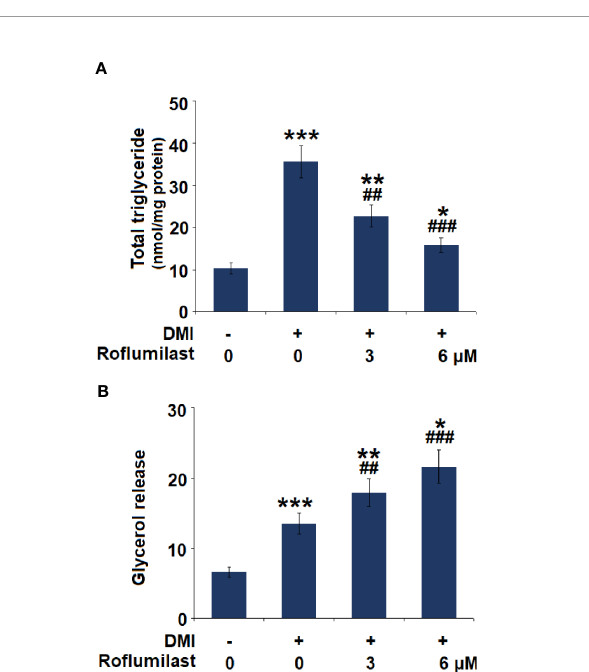
FIGURE 2 | Effect of Ro fl umilast on adipogenesis in 3T3-L1 cells. Cells were incubated with differentiation cocktail (DMI) medium with Ro fl umilast (3 and 6 m M). (A) Cells were stained with Oil Red O on day 8; (B) Lipid accumulation was examined by measuring absorbance at 540 nm of Oil Red O (*, **, ***, P < 0.05, 0.01, 0.005 vs. vehicle group; ## , ### , P < 0.01, 0.005 vs. DMI group, n = 6).